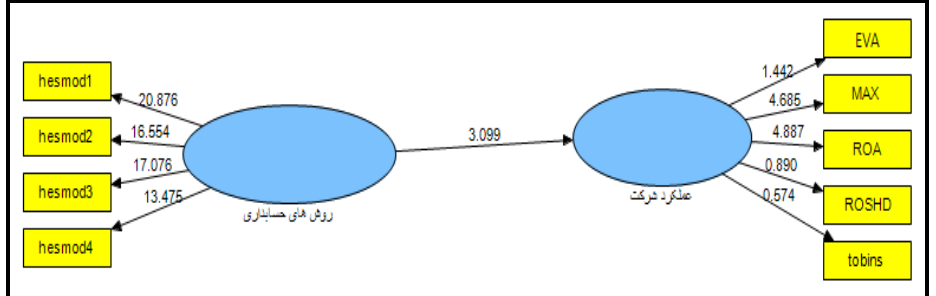
Figure 12. t-statistic for studying the significance of path